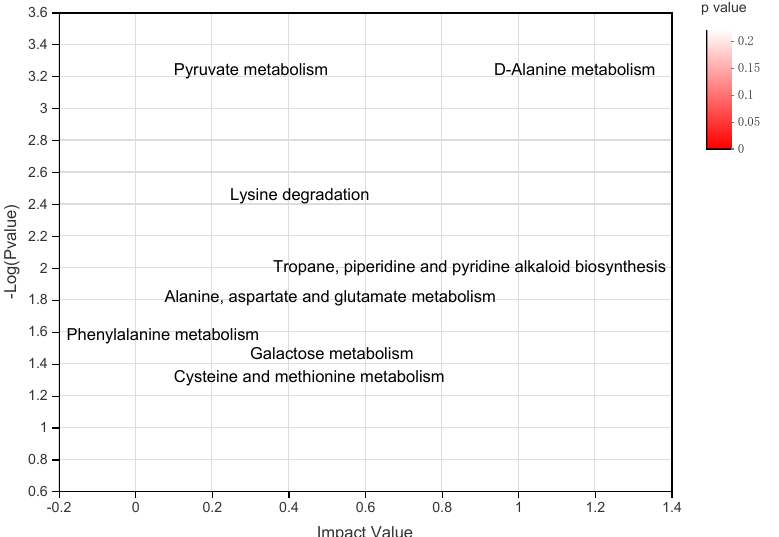
Figure 4. Key differential metabolic pathways characterize in the rumen fluid of buffalo under non-heat stress and heat stress conditions. The x -axis represents the pathway impact, and y -axis represents the pathway enrichment.